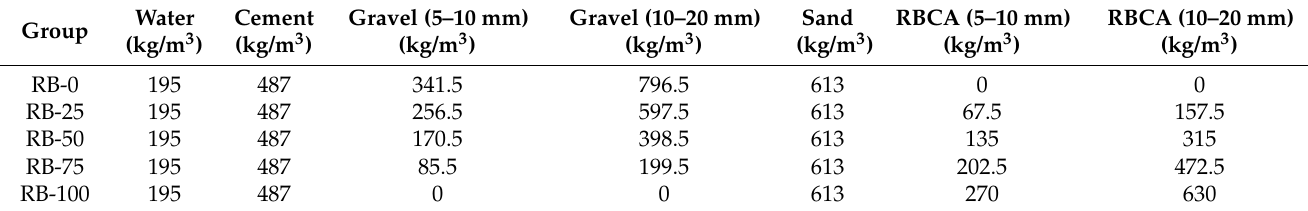
Table 2. Mix designs of recycled